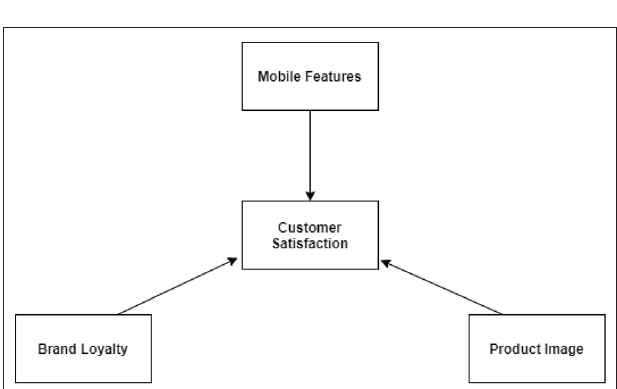
FIGURE 6 | Factor affecting customer